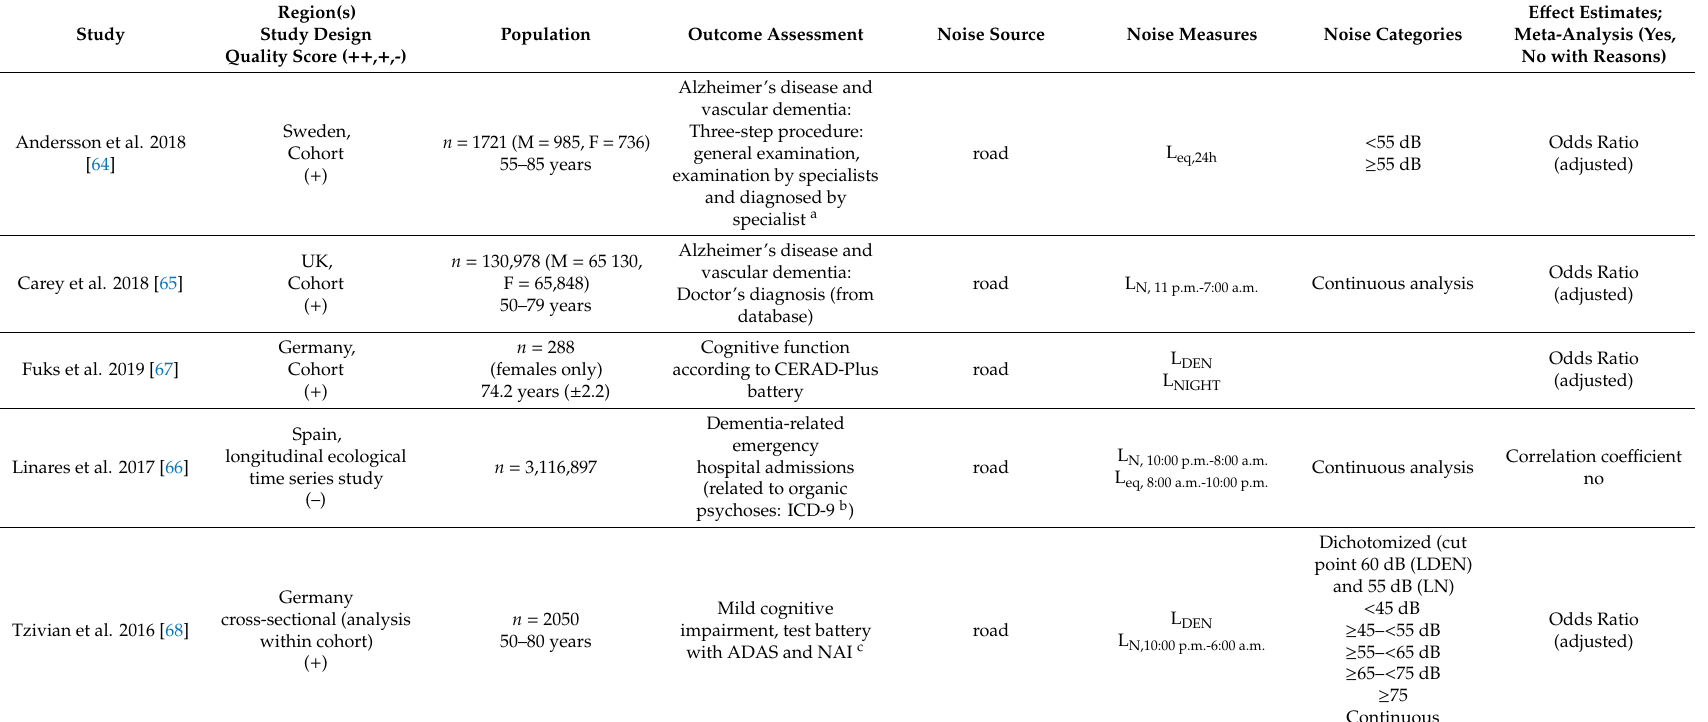
Table 5. Dementia and Alzheimer’s